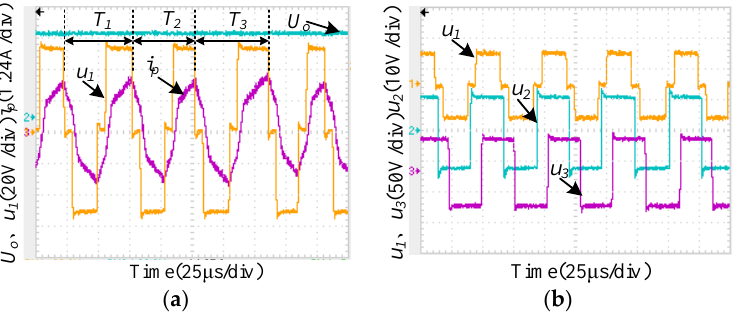
Figure 26. Measured waveforms of phase-shifted PWM control using continuously chaotic modulation: ( a ) converter voltage, current of port 1 and output voltage of port 2; ( b ) converter voltages of port 1, 2 and 3.